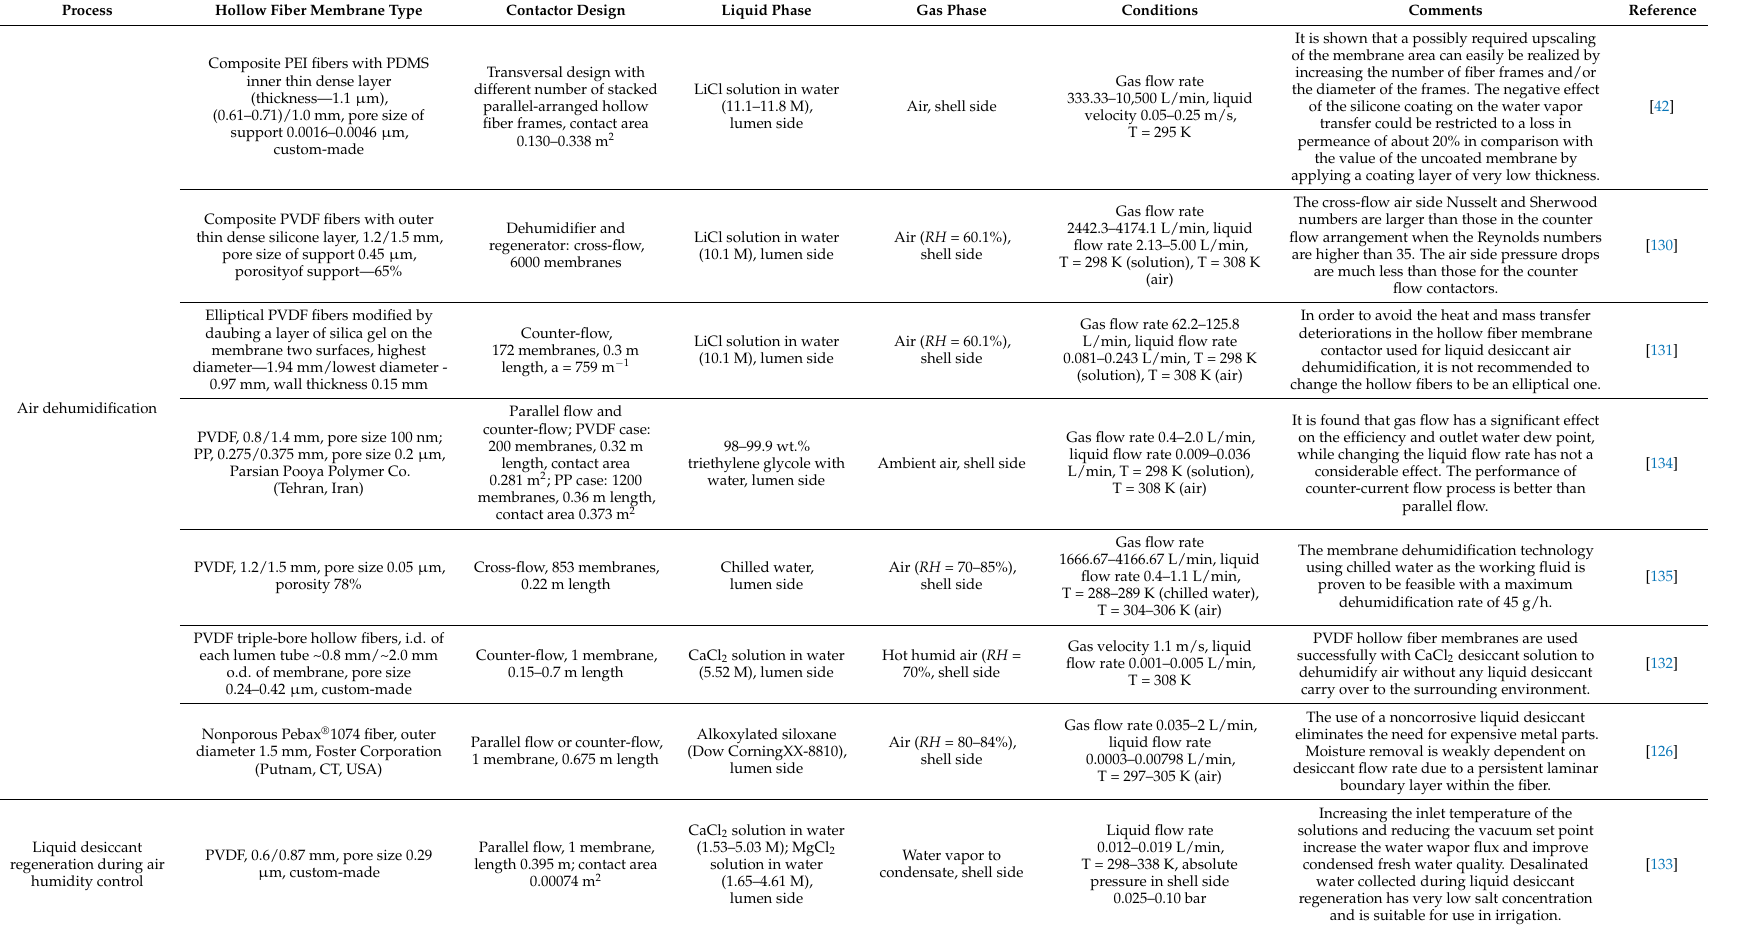
Table 6. Studies on gas humidity